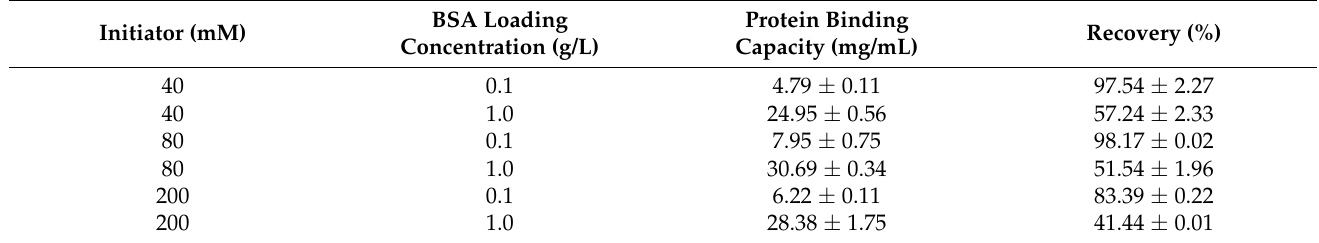
Table 2. The effect of ligand density and BSA concentration on DBC and recovery.